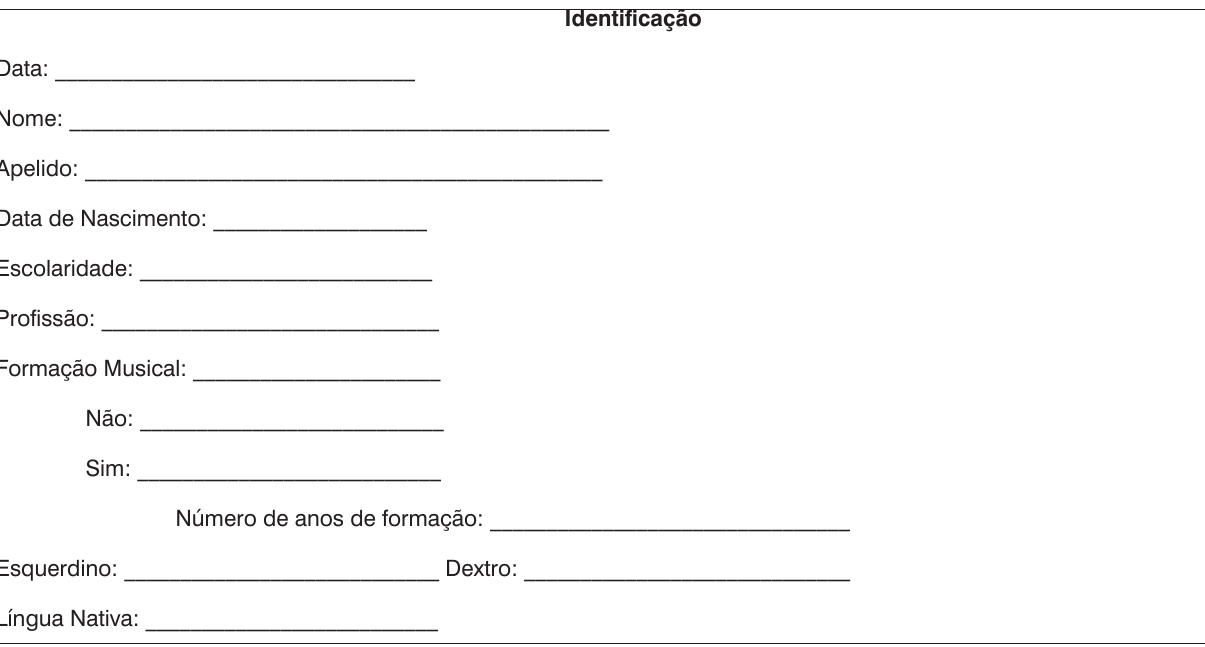
Figura 2. Instruções prestadas para a realização dos testes.